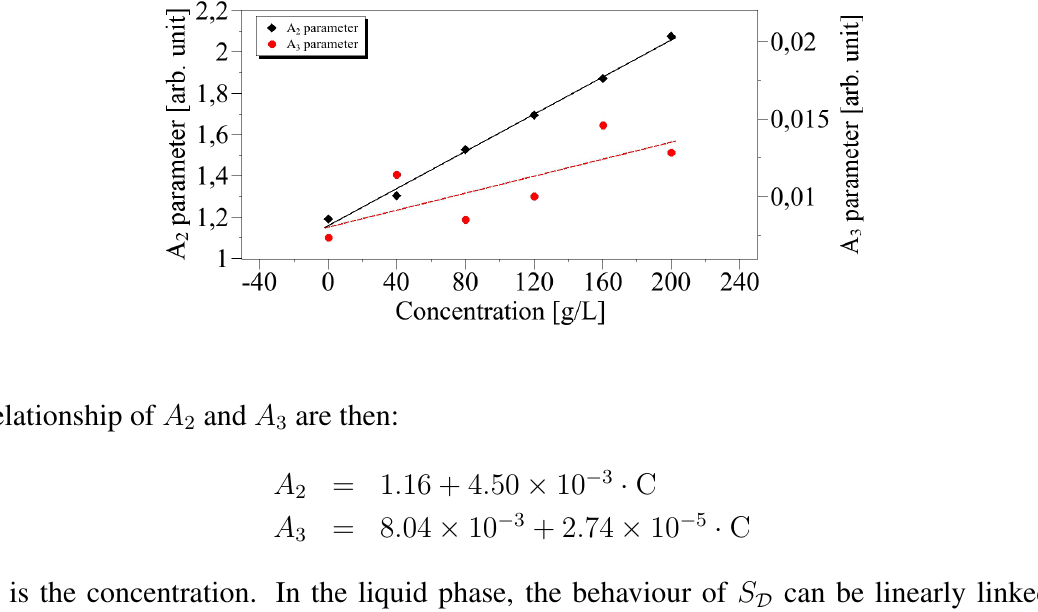
Figure 6. Linear relationship between the parameters A